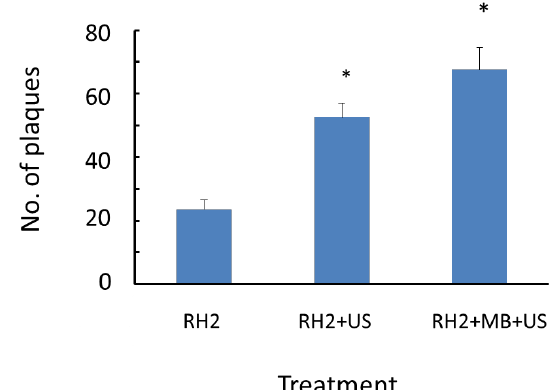
Figure 3. Effects of ultrasound immediately after the viral inoculation on HSV-1 plaque formation. SAS cells were inoculated with 1 × 10 4 PFU of HSV-1 RH2 with or without microbubbles. Thereafter, cells were exposed to ultrasound at an intensity of 1 W/cm 2 , and 20% duty cycle for 10 s. Cell monolayers were immediately washed with PBS to remove unbound virus and covered with medium containing methyl cellulose. For plaque assay, these cells were cultured at 37 °C for approximately 48 h. Results are means (± SD) of four determinations. * p < 0.05 significantly different from control (RH2).